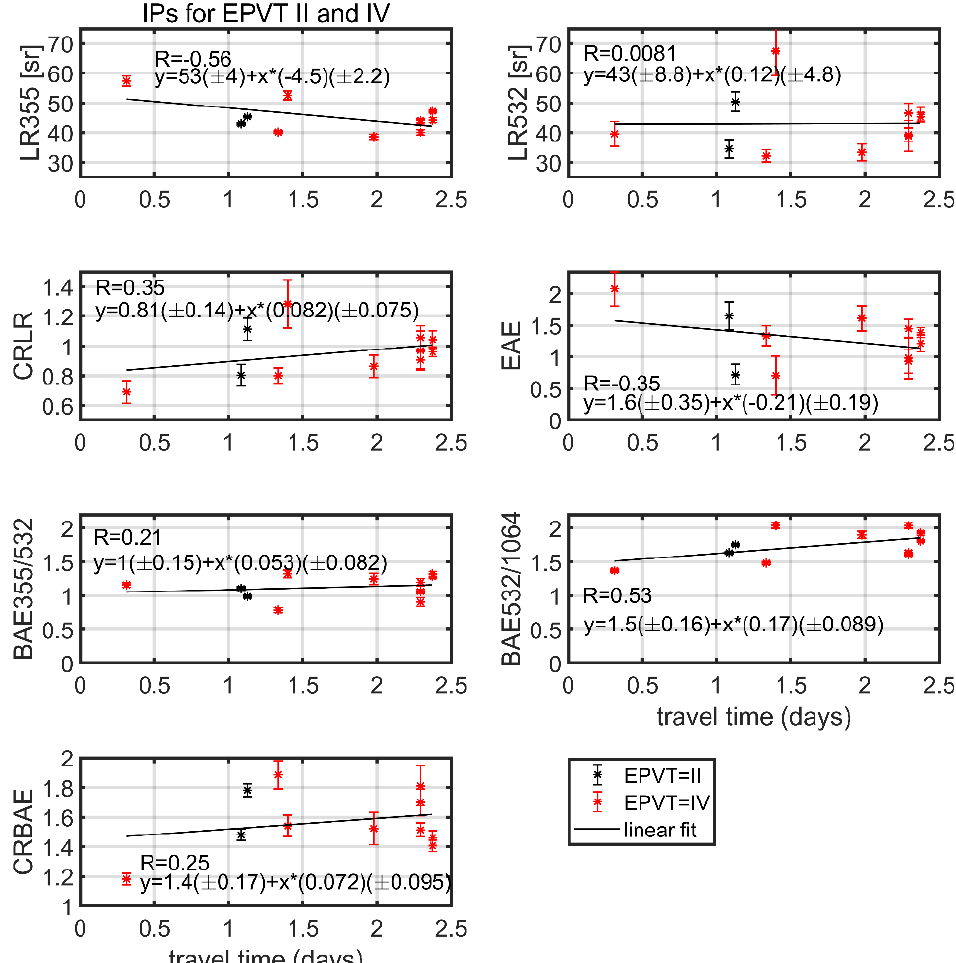
Figure 8. Intensive parameters versus smoke travel time.